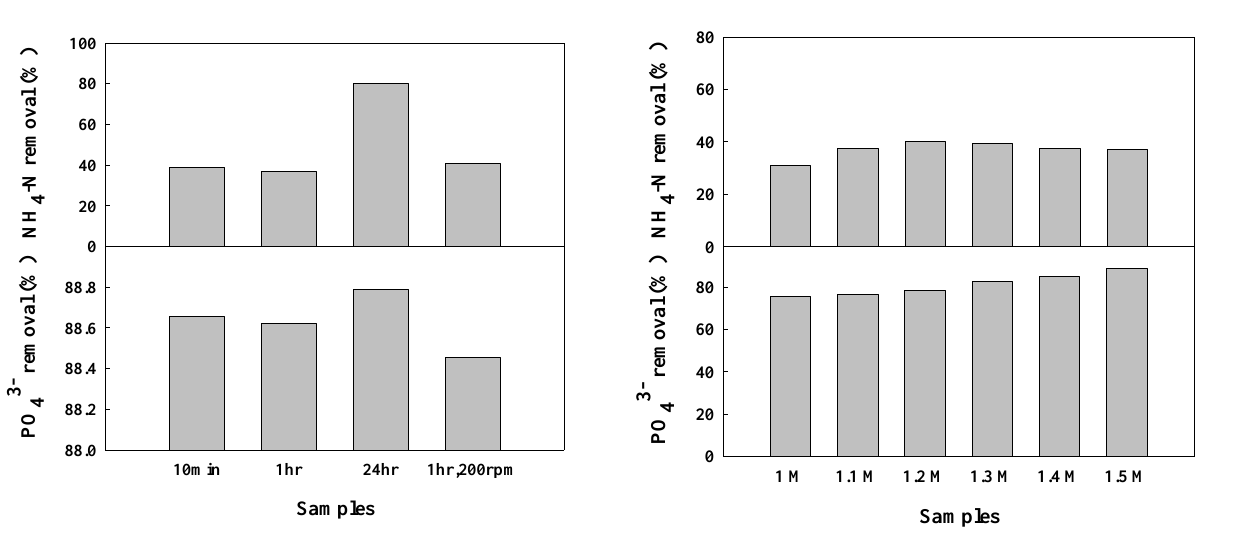
Figure 3. Effect of PO 42– -P to Mg 2+ mole ratio on the struvite crystallization of anaerobic digestive fluid of swine